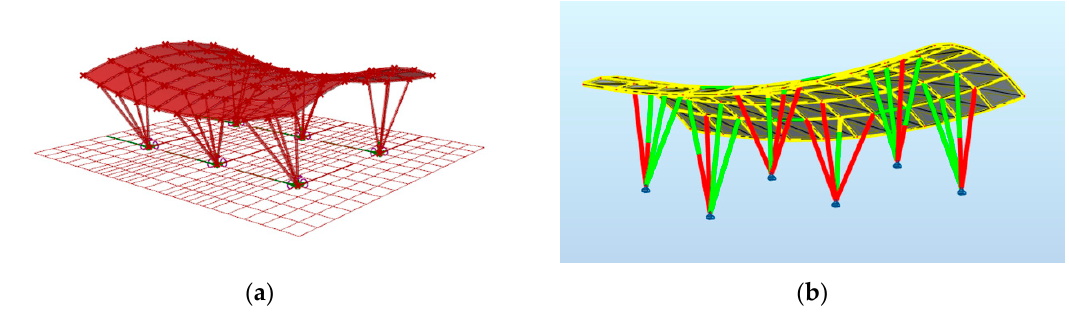
Figure 10. The roof supported by six groups of branches ( a ) Perspective view ( b ) Maps on bars – distribution of axial force F X.